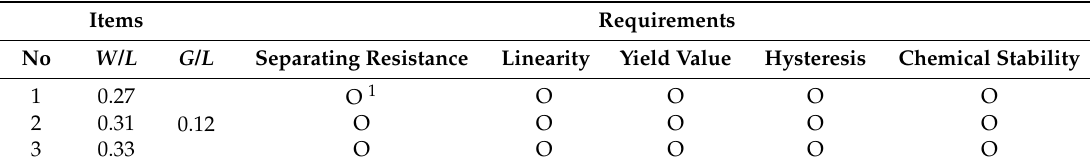
Table 5. Review of standard reference material requirements.